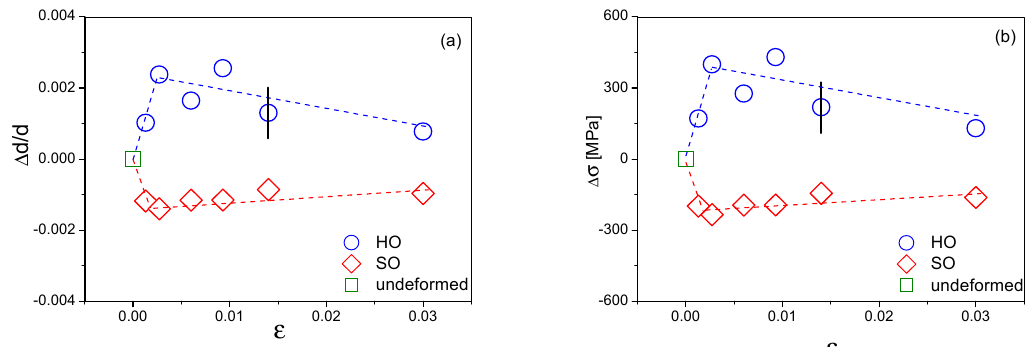
Figure 7. The averaged values of the relative shifts, Δ d/d, of the sub-peaks obtained from 200 and 310 reflections and both axial- and side cases ( a ) and the long-range internal stress values, Δσ ( b ) as a function of true strain. The vertical thick black lines indicate the experimental error.